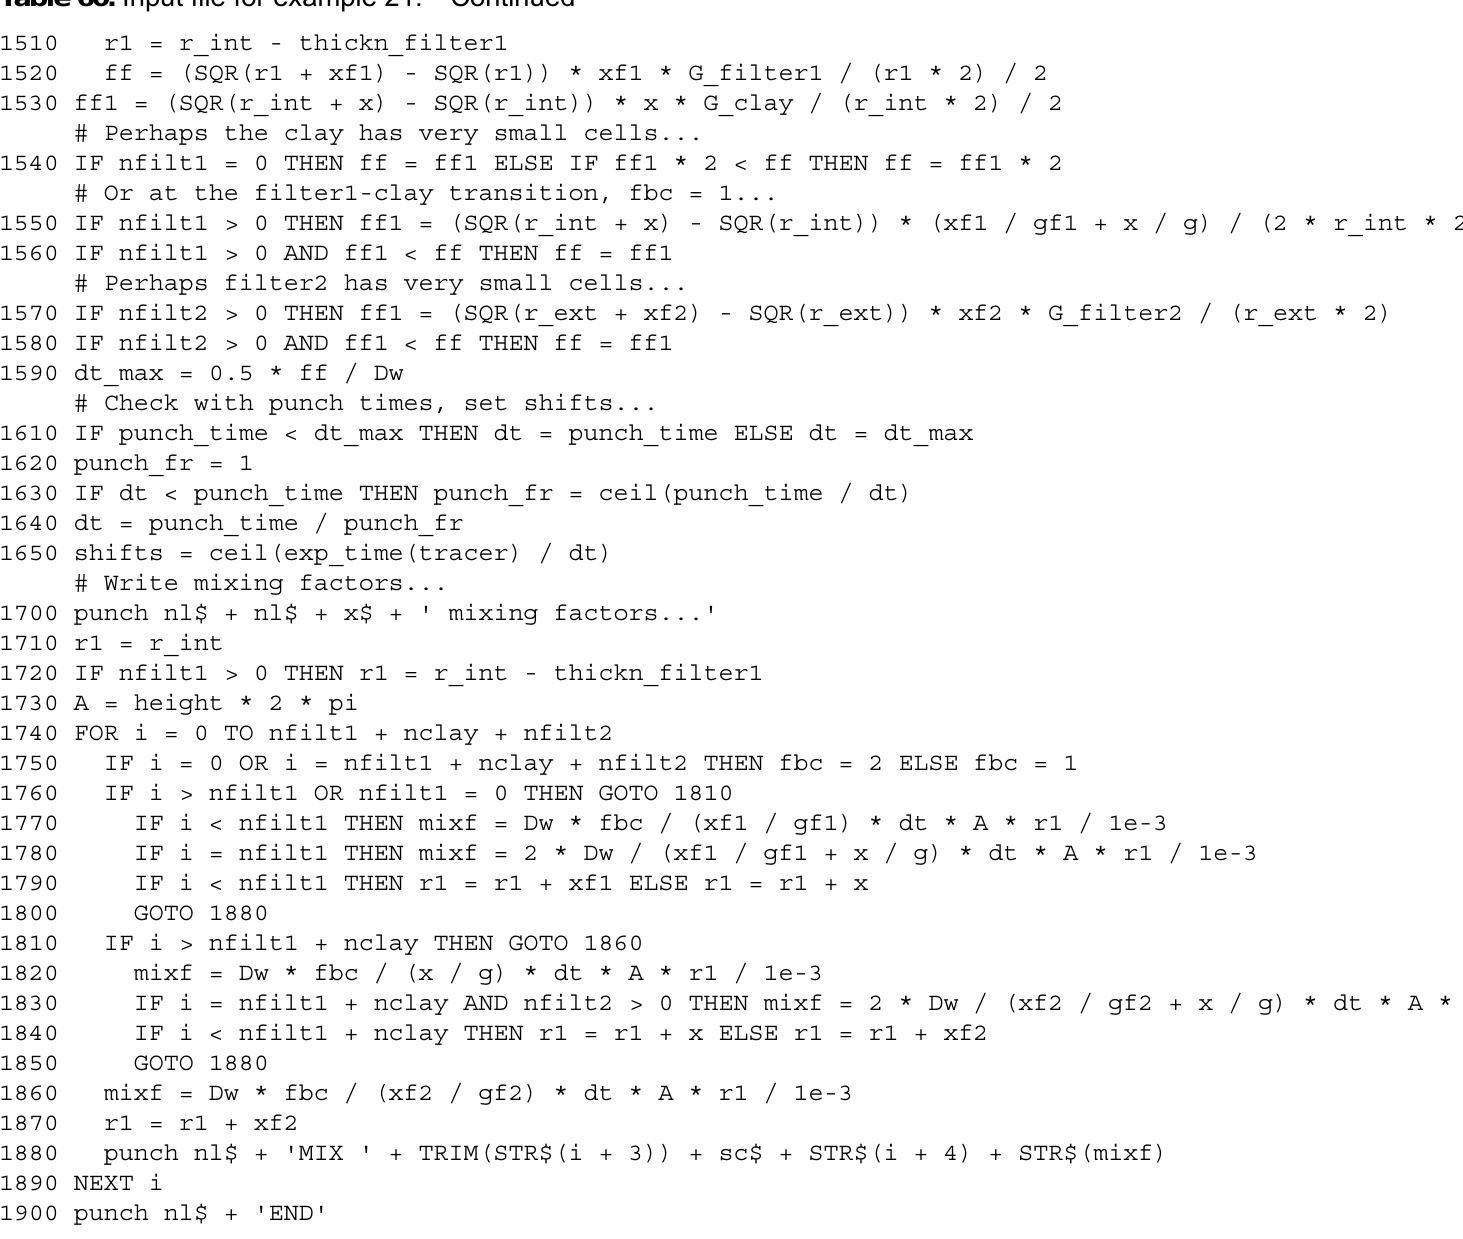
Table 60. Input file for example